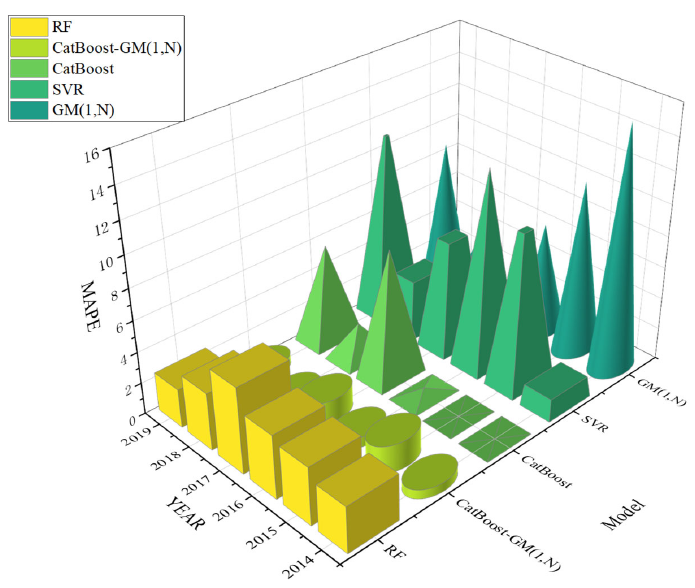
Figure 3. MAPE values for building industry VOCs emissions in China, 2014–2019.